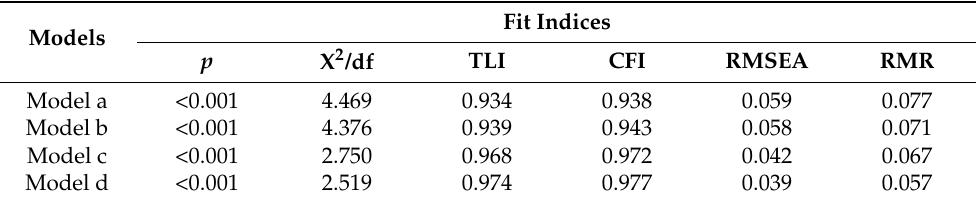
Table A1. Fit measures for the DEBQ